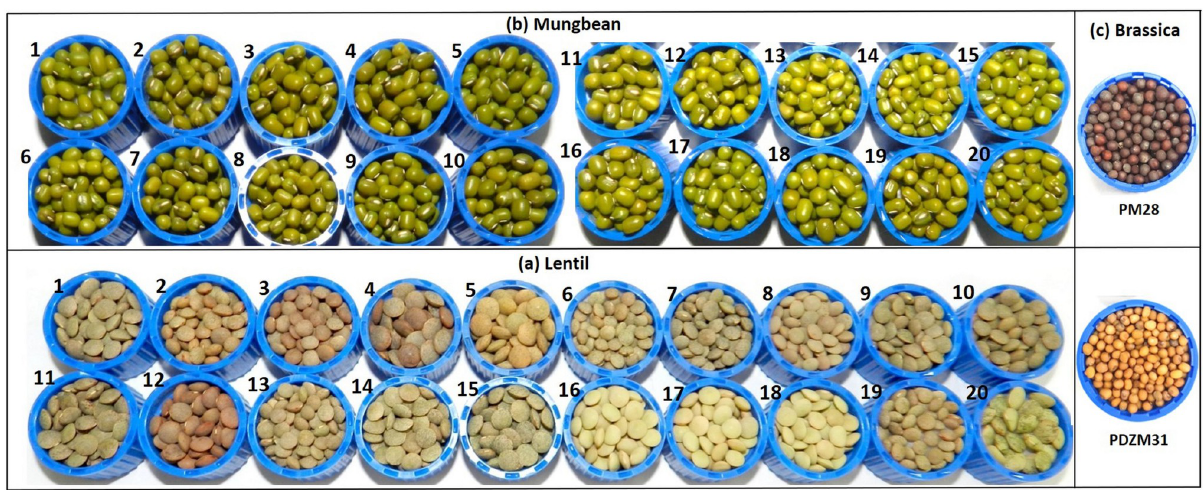
Fig 1. The mungbean, lentil, and Indian mustard genotypes used in the study. Where (a) mungbean genotypes are 1. Pusa Baisakhi, 2. Pusa Ratna, 3. Pusa Vishal, 4. Pusa105, 5. Pusa0672, 6. Pusa9072, 7. Pusa9531, 8. MH96-1, 9. MH318, 10. MH421, 11. MH521, 12. MH810, 13. ML512, 14. ML818, 15. PS16, 16. TM 96–2, 17. IPM02-3, 18. IPM02-14, 19. IPM409-4, 20. PMR1; (b) lentil genotypes are 1. L4076, 2. L4147, 3. L4594, 4. L7903, 5. HM1, 6. BM4, 7. JL1, 8. Sehore74-3, 9. NDL1, 10. IPL81, 11. IPL321, 12. K75, 13. KLS218, 14. DPL58, 15. DPL62, 16. PL1, 17. PL2, 18. PL6, 19. L830, 20. L4602; while (c) Indian mustard genotypes were 1. PM28 and 2.